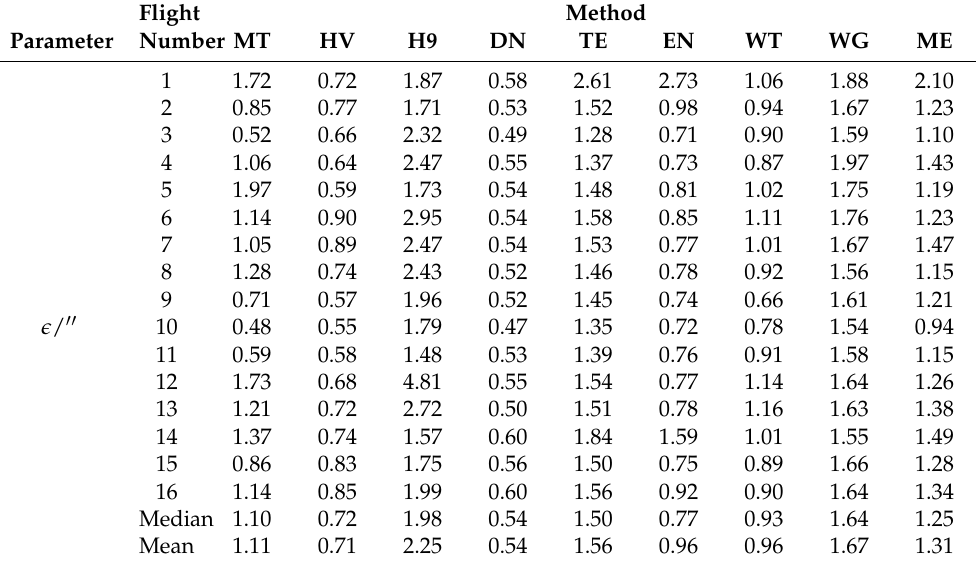
Table A4. ECACN integrated astronomical parameters details ( (cid:101) @ λ = 550 nm). Flight